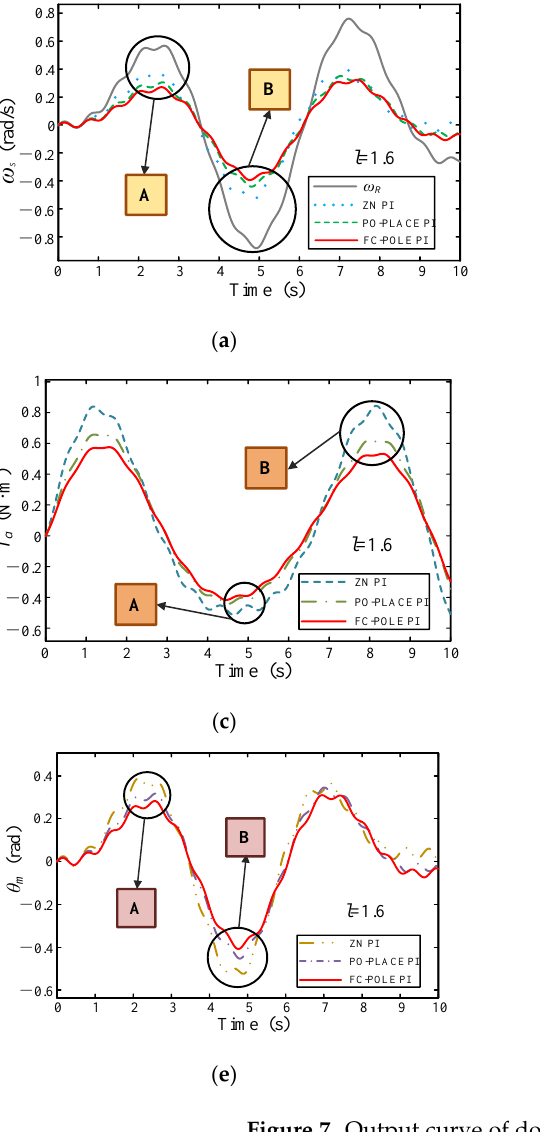
Figure 6. Output curve of double flexible body under parameter 1: ( a ) system rotation frequency diagram; ( b ) local amplification diagram of rotation frequency; ( c ) system torque diagram; ( d ) local amplification diagram of system torque; ( e ) system output angle diagram; ( f ) local magnification of system output angle.